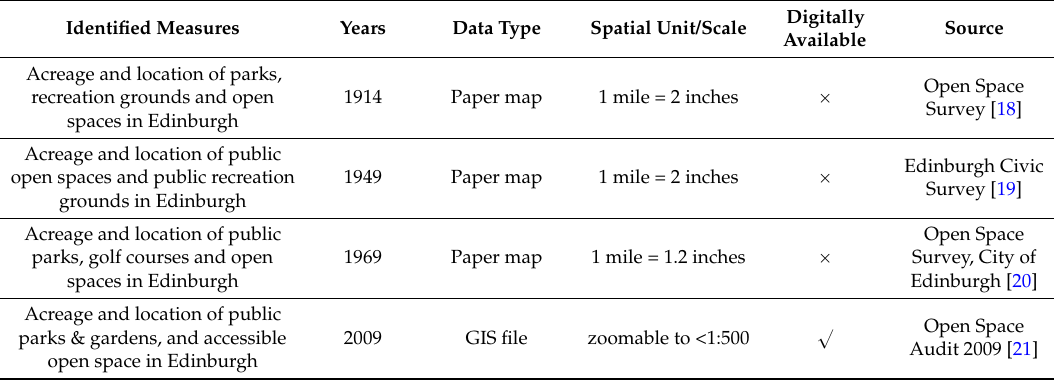
Table 2. Available data sources for capturing local green space in Edinburgh over